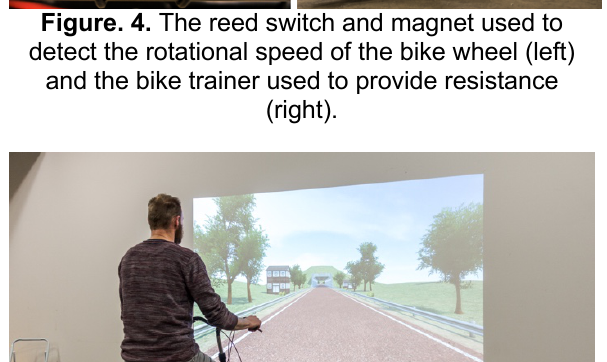
Figure. 2. Prototype of SocialBike’s on-bike display.